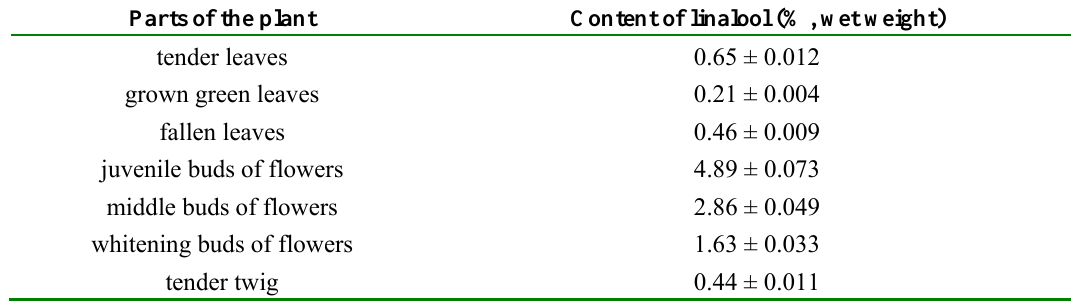
Table 1. The content of linalool in the different parts of plant Michelia